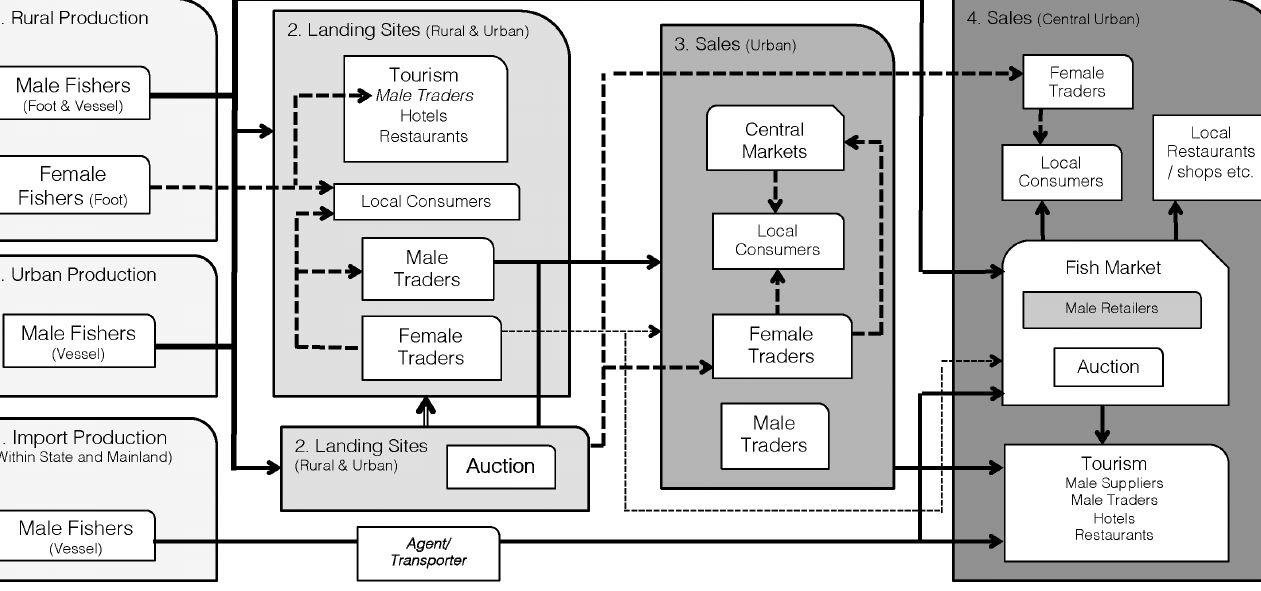
Figure A5.2: Market structure for Unguja Island (Zanzibar). Dotted arrows represent the product being sold by women actors, the bold line represents men actors and the double line shows both women and men's transactions. Different sized arrows are used only for